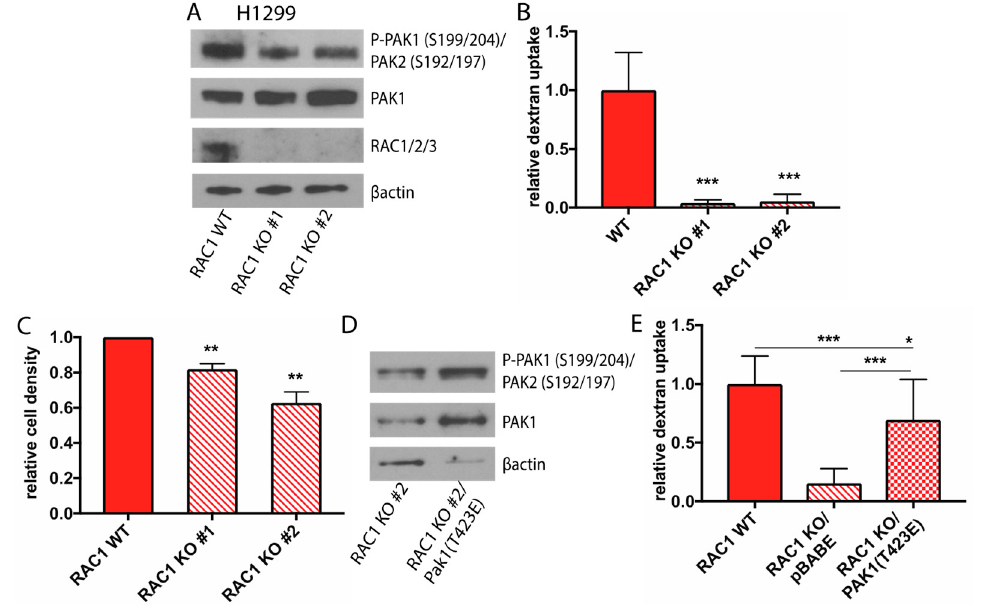
Figure 4. Rac1 expression activates macropinocytosis in H1299 cells in a PAK dependent manner and is necessary for glucose independence. ( A ) Immunoblot analysis comparing Rac signaling in Rac1 WT and Rac1 KO H1299 cells generated using CRISPR-Cas9 technology. The two knockout clones were generated using two independent guides against Rac1. ( B ) Quantification of the levels of FITC-dextran uptake in glucose starved H1299 Rac1 WT and H1299 Rac1 KO cells. Data is normalized to Rac1 WT cells, error bars indicate ± SD of 10 fields scored containing at least 10 cells. ( C ) Relative density of Rac1 WT and H1299 Rac1 KO cells cultured in GFM for 48 h as determined by crystal violet staining. Data is normalized to density of Rac1 WT cells at 48 h, error bars indicate ± SEM of three independent experiments. For ( B , C ), significance was calculated using Student’s t -test. ( D ) Immunoblot analysis of Pak signaling in Rac1 KO H1299 control cells or cells stably overexpressing the constitutive active Pak1 mutant T423E. ( E ) Quantification of the levels of FITC-dextran uptake in glucose starved Rac1 WT, Rac1 KO, and Rac1 KO/Pak1 (T423E) cells. Data is normalized to Rac1 WT cells; error bars indicate ± SD of 10 fields scored containing at least 10 cells. Significance was calculated using ANOVA with Holm-Sidak multiple comparisons across cell lines, * p < 0.05, ** p < 0.005, *** p < 0.0001.